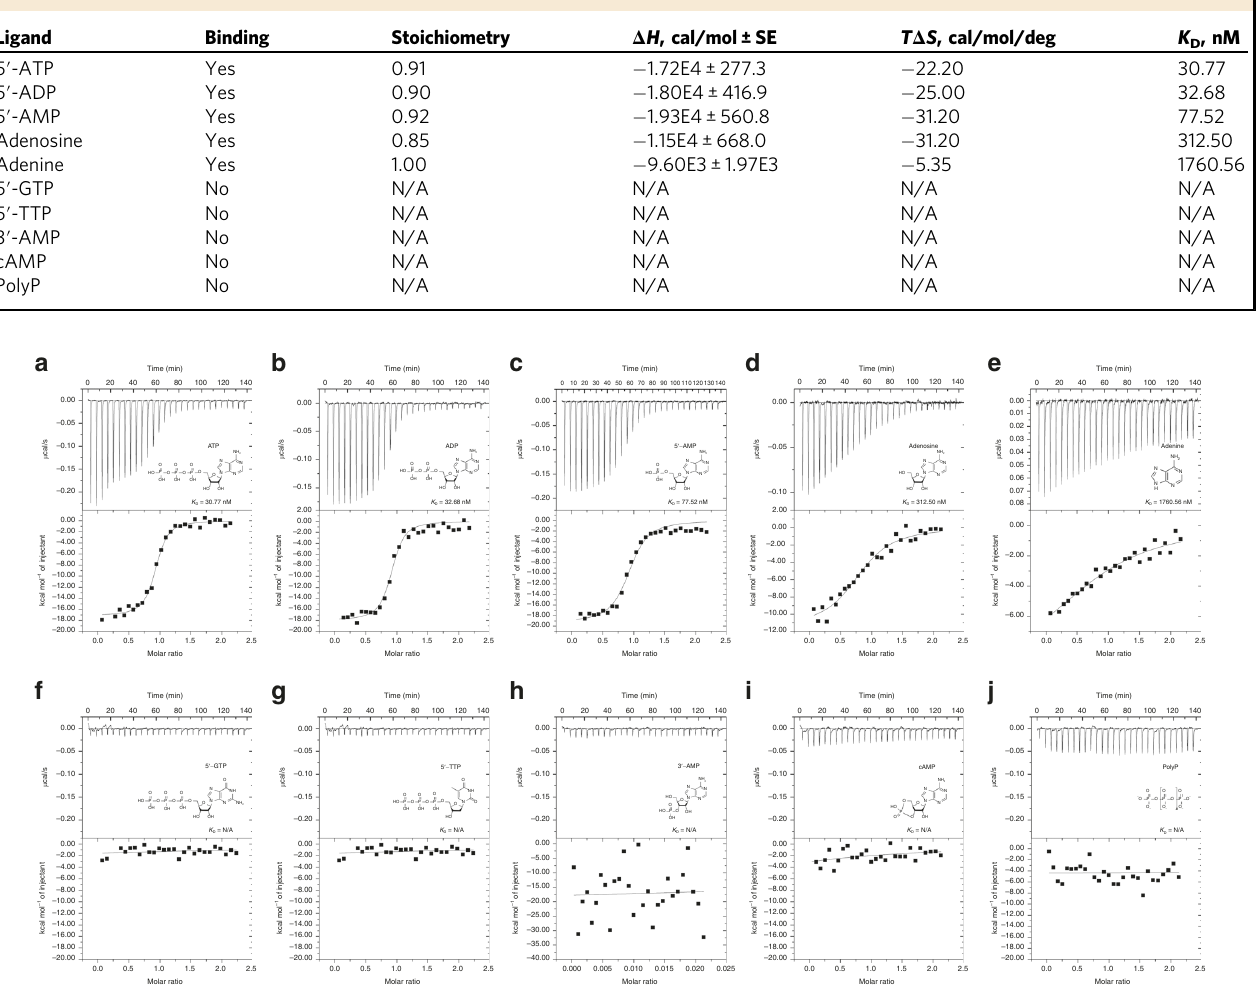
Fig. 2 Binding of nucleosides and related molecules to CxD7L1 by ITC. Binding experiments were performed on a VP-ITC microcalorimeter. Assays were performed at 30 °C. The upper curve in each panel shows the measured heat for each injection, while the lower graph shows the enthalpies for each injection and the fi t to a single-site binding model for calculation of thermodynamic parameters. Titration curves are representative of two measurements. Panels ( a – e ) show adenine nucleosides or nucleotides that bind CxD7L1: adenosine 5-triphosphate ( a ), adenosine 5-diphosphate ( b ), adenosine 5-monophosphate ( c ), adenosine ( d ), and adenine ( e ). In panels ( f – j ), other purine and pyrimidine nucleotides and related substances showed no binding to CxD7L1: guanosine 5-triphosphate ( f ), thymidine 5-triphosphate ( g ), adenosine 3-monophosphate ( h ), cyclic adenosine monophosphate ( i ), and polyphosphate ( j ). The insets show the names and chemical formulas for these